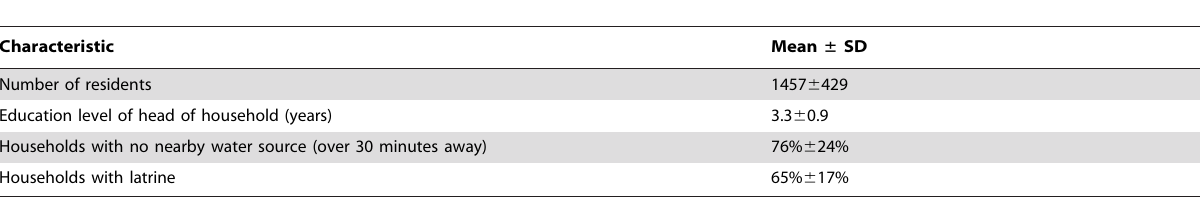
Table 1. Mean characteristics of 32 communities at baseline.